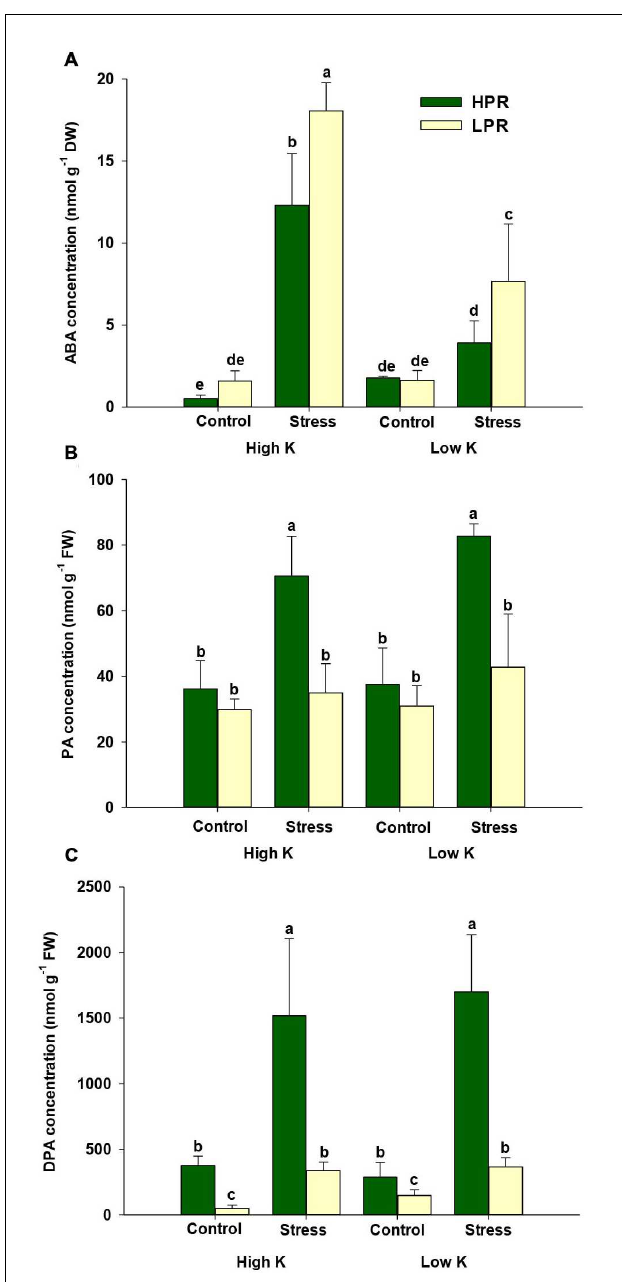
FIGURE 4 | Influence of K supply on ABA homeostasis in flag leaves of barley during terminal drought stress. Concentrations of (A) abscisic acid (ABA), (B) phaseic acid (PA), and (C) dehydro-phaseic acid (DPA) in flag leaves of the lines HPR and LPR. Plants were pre-cultured under sufficient water supply (control) or water limitation (stress) and under low or high K supply. Flag leaves from 12 weeks-old plants were harvested 12 days after imposing drought stress. Bars indicate mean ± SD. Different letters denote significant differences according to three-way ANOVA and Tukey’s test ( p < 0.05; n = 6).